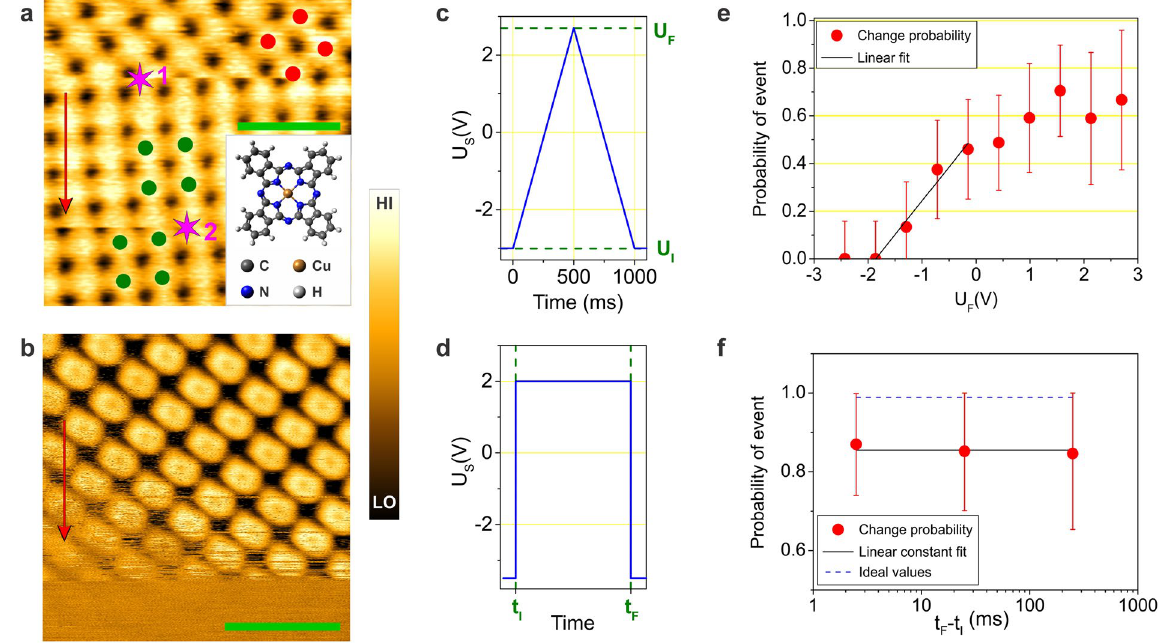
Figure 1. Field-induced switching of the CuPc self-assembled molecular array. ( a ) Change of a domain orientation (1) and position (2) as a response to voltage pulses. Purple stars mark positions above which the pulses were applied. The image was taken at the sample bias U s = − 2.3 V. The inset depicts the structural model of a CuPc molecule. Red and green dots mark positions of molecules in the molecular structures with different orientations. ( b ) STM image of the CuPc molecular array taken at the sample bias of − 1.7 V, which is close to the threshold of imaging the stable arrays. Red arrows indicate the scanning direction. Green bars denote the length of 3 nm. ( c , e ) Shape of the triangular voltage pulse and corresponding dependence of the domain change probability on the peak voltage of the pulse U F . The values of probability were acquired from the 320 voltage pulses applied over the same domain. ( d , f ) Shape of the rectangular voltage pulse and corresponding dependence of the domain change probability on the pulse duration. The results were acquired from 100 voltage pulses applied over the same domain. Dashed line denotes ideal probability of random switching in a system of 45 domains (see Supplementary). The error bars represent a range of two standard deviations. Note that absolute values of the voltages and probabilities can vary for different STM tips and different surface coverages, but the character of the measured probability dependence remains the